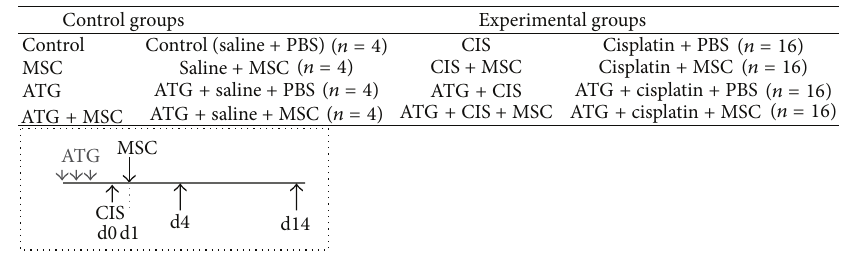
Figure 1: Shematic representation of the protocol and all control and experimental